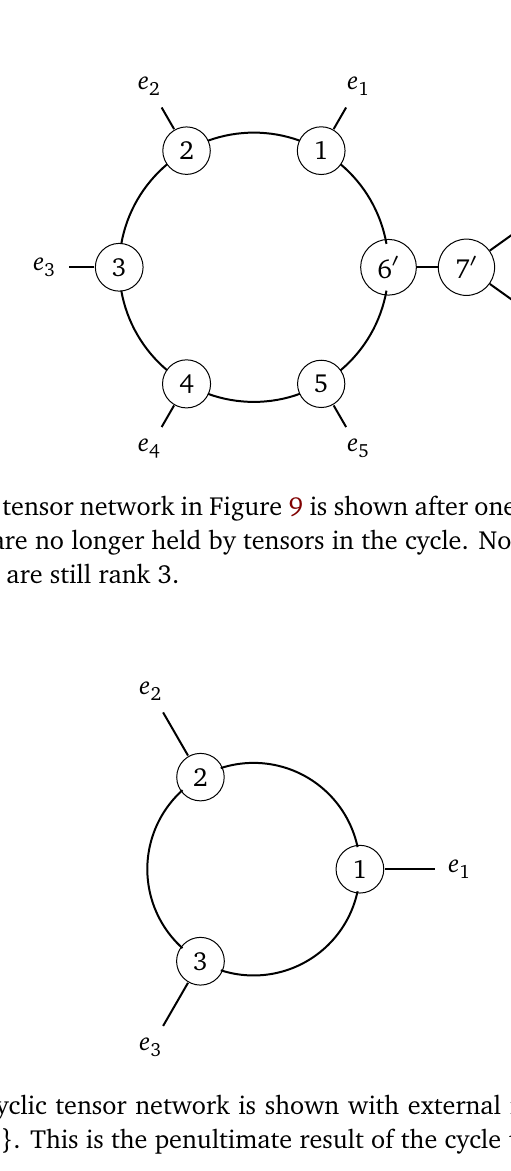
Figure 14: The result of factoring the tensor T in Figure 13 is shown. The new tensors A and B are the focus, and edges leading away from them towards the rest of the cycle are shown in blue connecting to blue circles (tensors) while those leading out of the cycle are shown in orange. Note that A is contained in the cycle because it connects to tensors 1 and 5 while B is not in the cycle, connecting only to A and the external indices e and e . 6 7